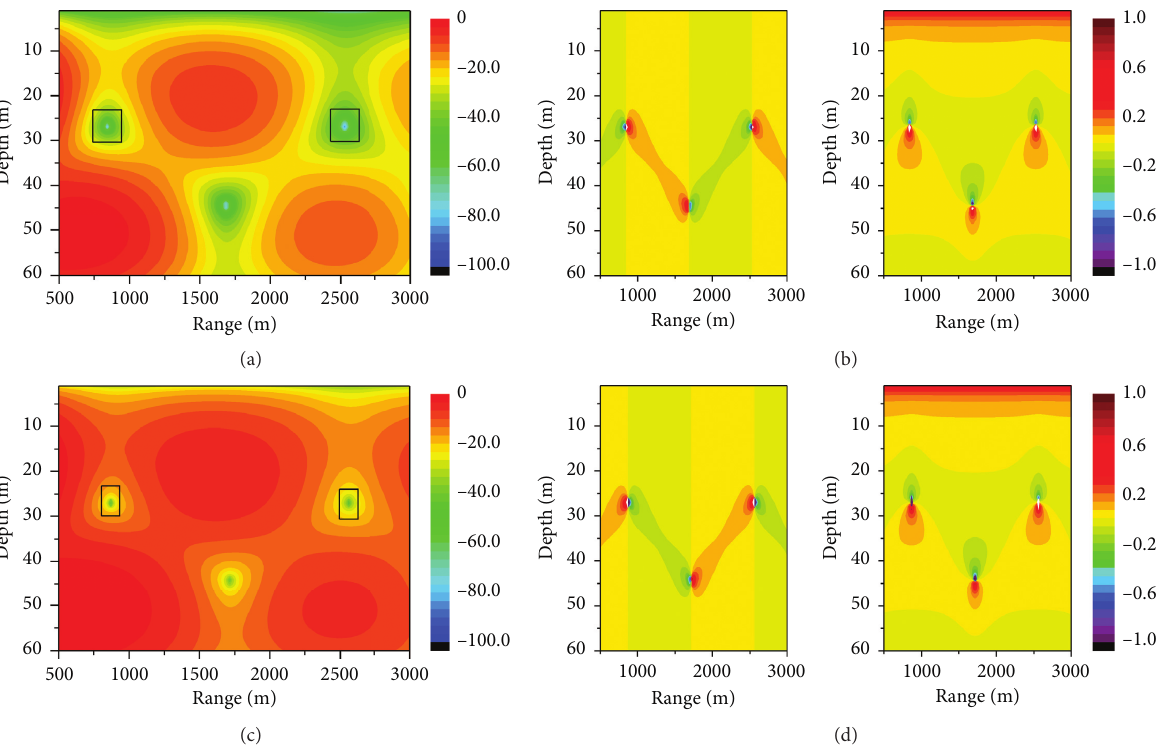
z ; right: Q ∗ z ; right: z );